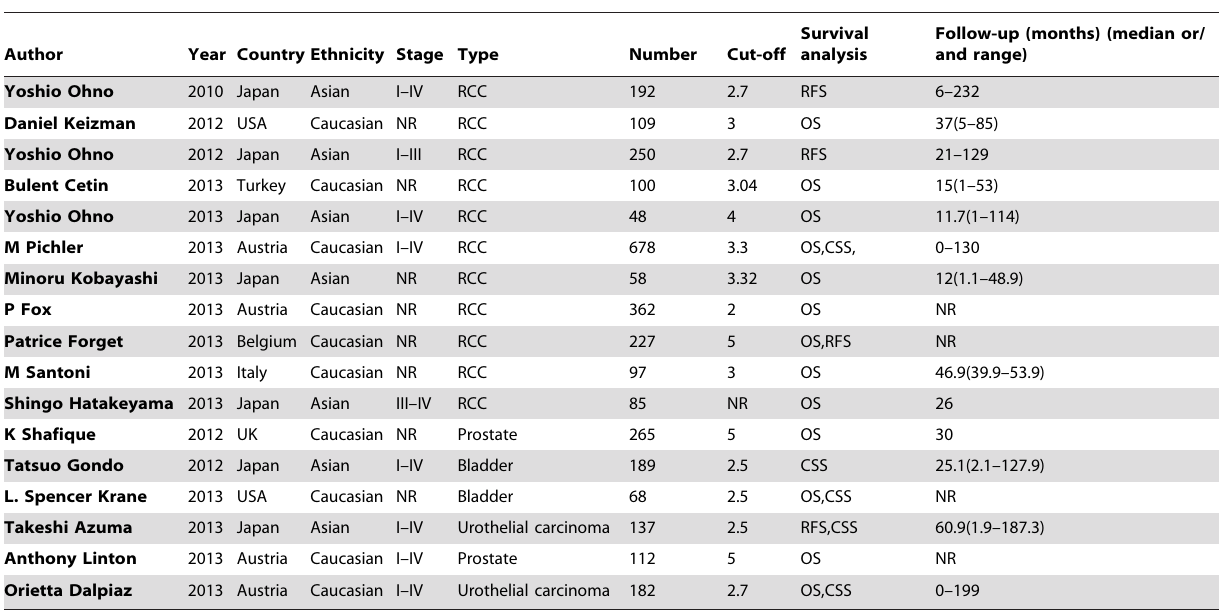
Table 1. characteristics of all the